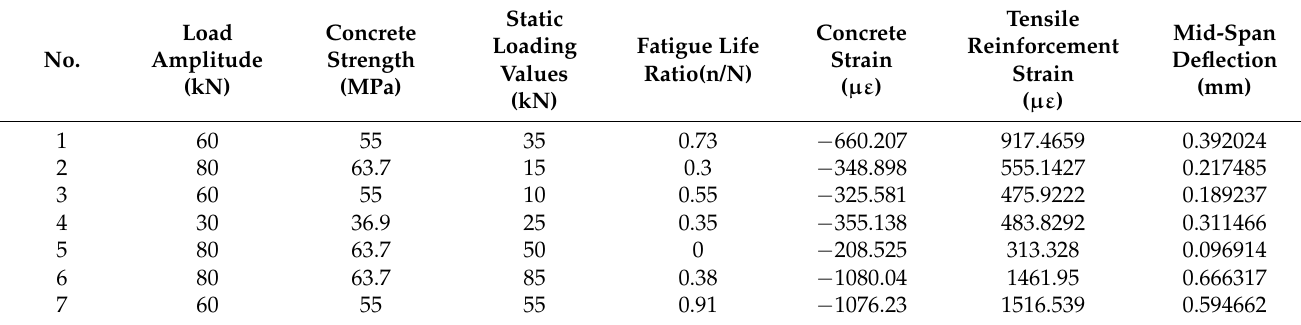
Table A1. The experimental data